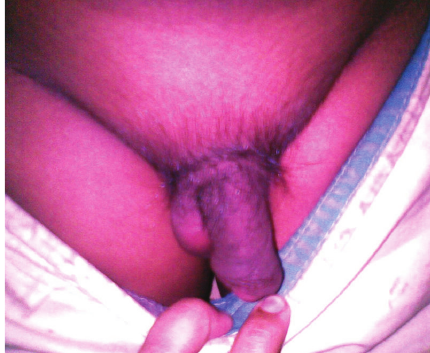
Figure 2: The unexpected finding of enlarged phallus more than normal for age and growth of child and coarse pubic hair.